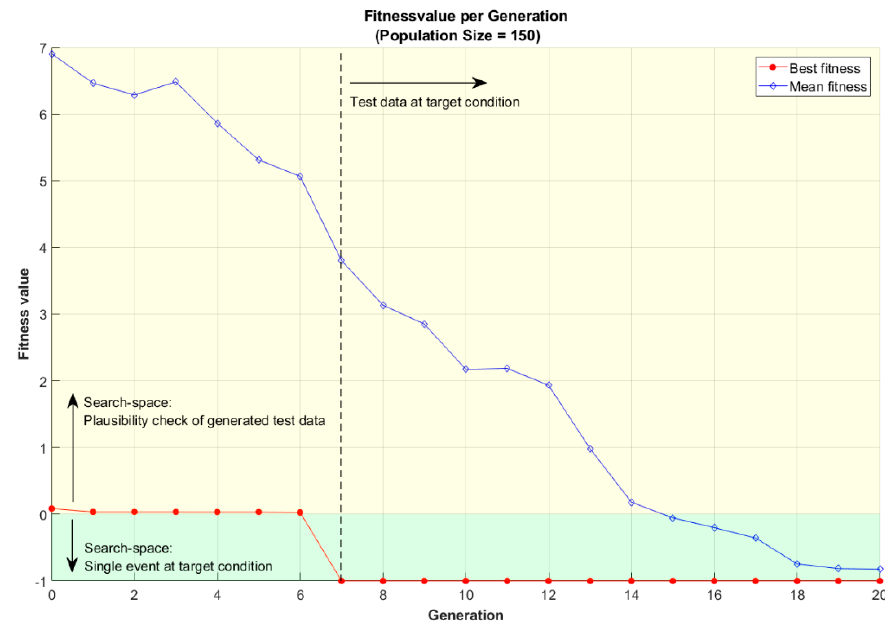
Figure 14. Case 1—Single event: fitness value evolution after test execution.